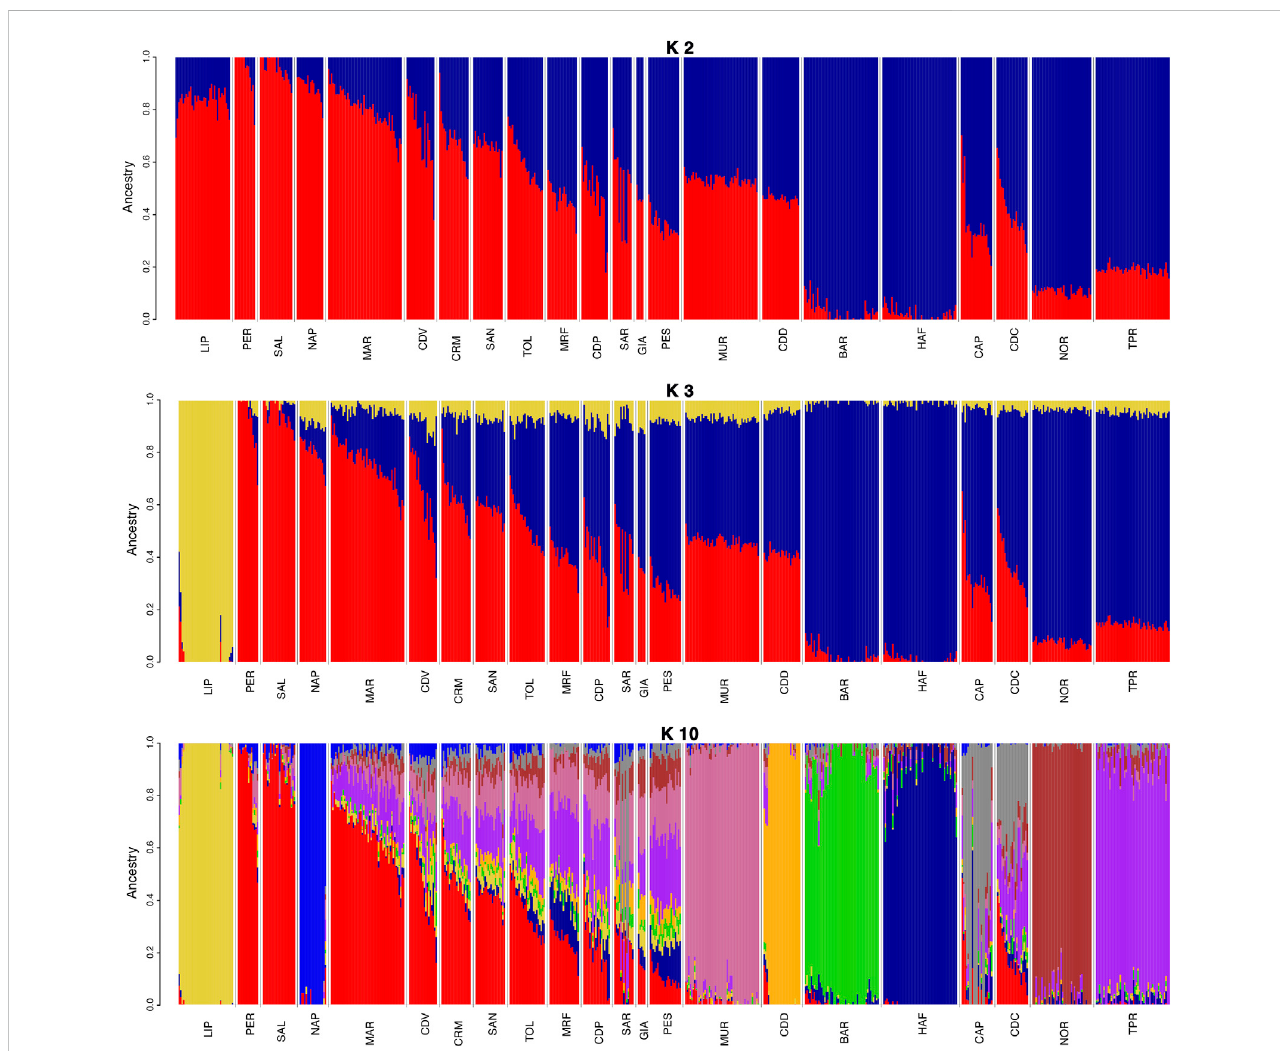
FIGURE 3 AdmixtureplotwithKvalues2,3,and10fortheItaliandataset.TheclusteringofBardigiano(BAR)occursatK=4,CavallodelDelta(CDD)atK=5,Cavallo Agricolo Italiano da TiroPesante Rapido (TPR) atK= 6, Murgese (MUR) atK= 7, Noriker (NOR) atK =8, Monterufolino (MRF) atK= 9, andNapoletano(NAP)at K = 10. Full list of used acronyms is available in Supplementary Table